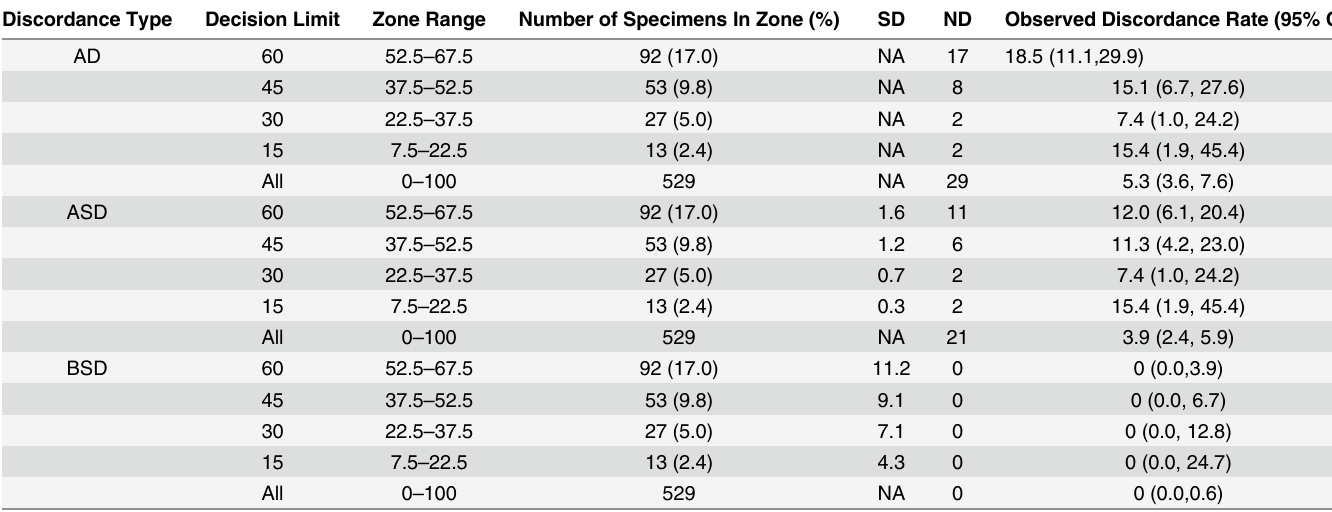
Table 2. Discordance rate by eGFR decision point.